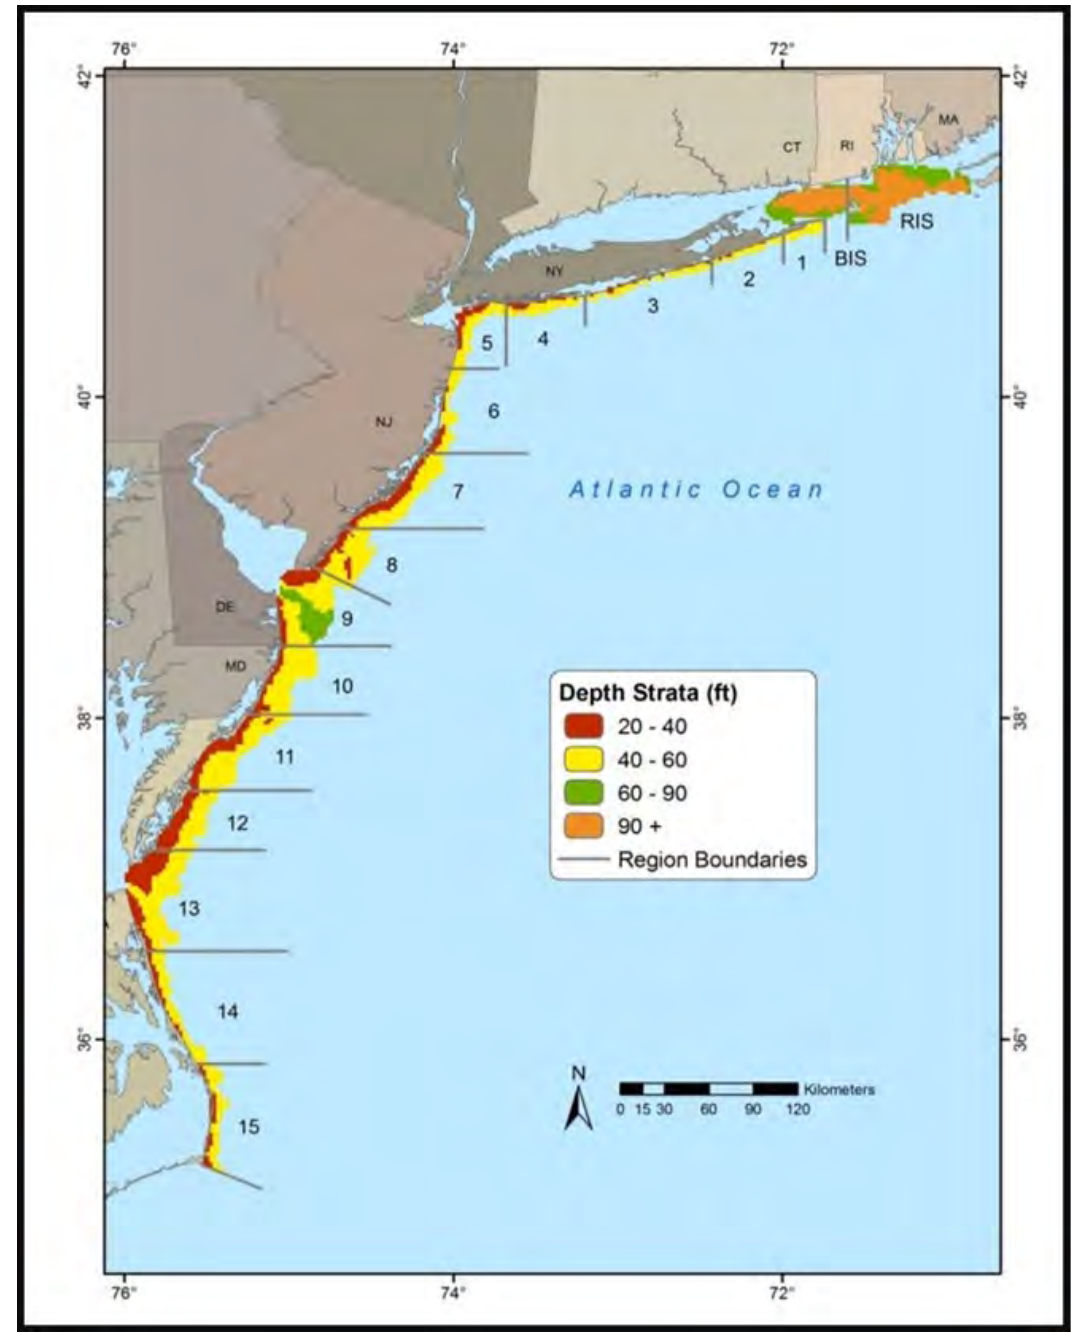
Figure 39. Map of the sampling strata used in the NEAMAP survey (map provided by NEAMAP and available on the website